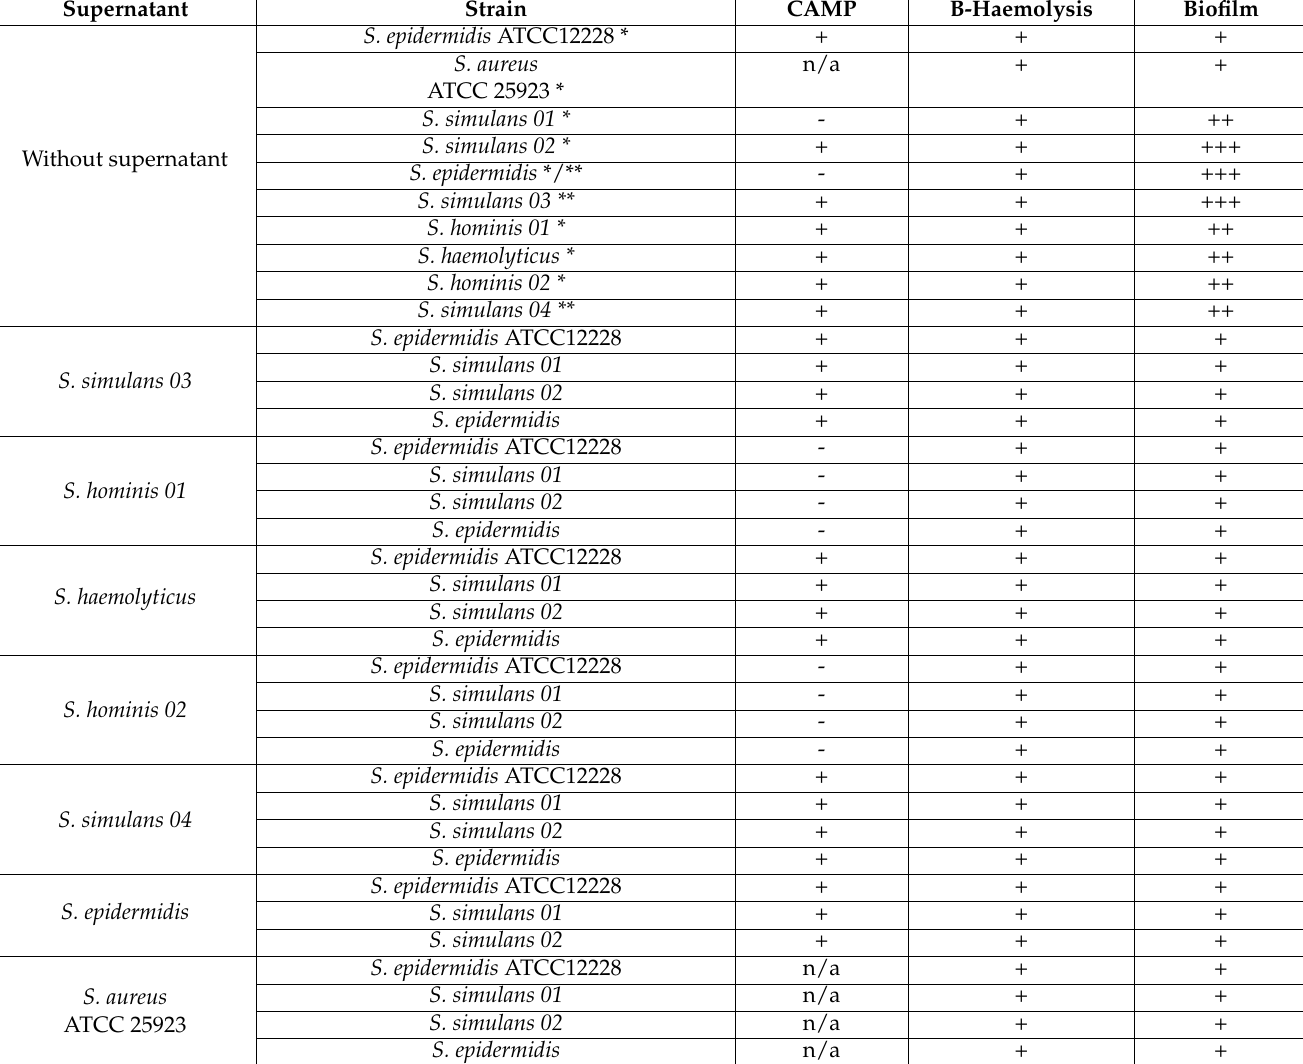
Table 4. The cross-talk between isolates from the same as well as different species. Supernatant Strain CAMP B-Haemolysis Biofilm